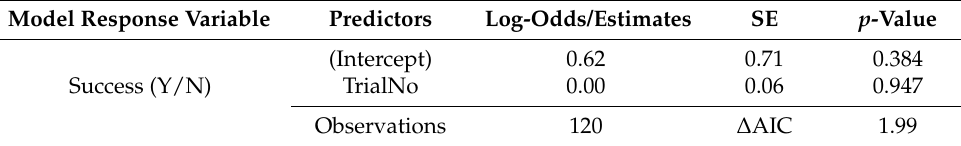
or non-matching stimuli (Chi-squared = 0.29, p = 0.59, Figure